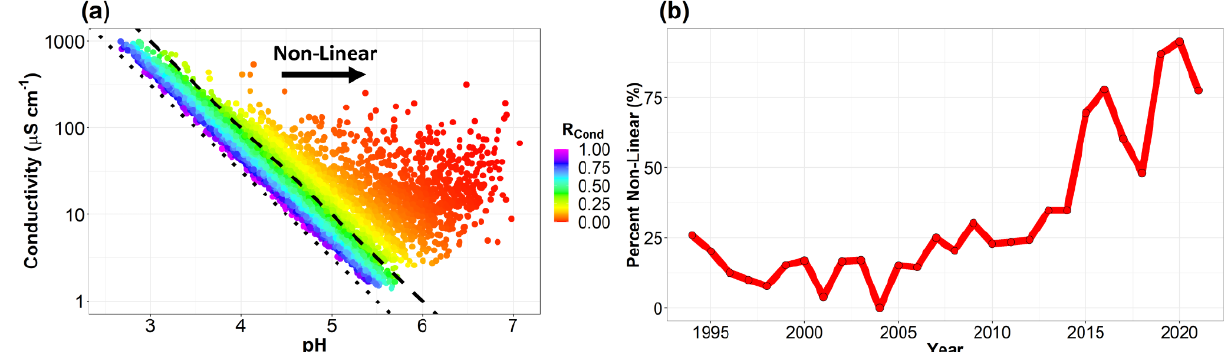
Figure 7. (a) Conductivity and pH for individual cloud water samples from 1994 to 2021. The linear and non-linear regimes are distinguished with a dashed line that indicates H + contribution to the measured conductivity is exactly 35%. To the right of this line, H + contributes less to the measured conductivity, and we refer to this as the non-linear regime, since conductivity and pH no longer exhibit a clear linear relationship. The dotted line represents the conductivity if H + is the only ion present. (b) Percent of samples in the non-linear regime for each year of sampling at WFM. Table 1. Linear versus non-linear regime median concentrations for all measured analytes and associated p values for the Dunn test. Chemical species Non-linear Linear Difference % Difference p value Non-linear Linear median